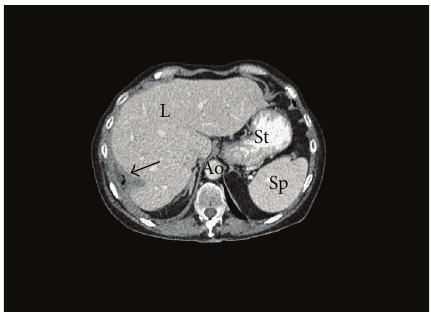
Figure 4: Computed tomography showing a complete healing of the subphrenic abscess (arrow); aorta (Ao); liver (L); spleen (Sp); stomach